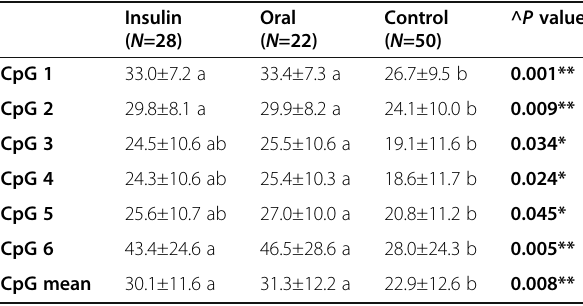
Table 2 Comparison of IGFBP-1 DNA methylation of the six combined CPG sites in the studied